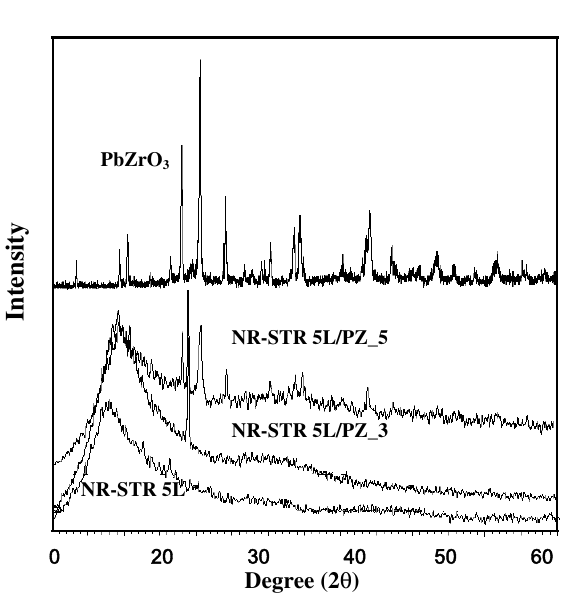
Fig. 2. XRD patterns of natural rubber (NR-STR 5L), lead zirconate (PbZrO 3 Þ , NR-STR5L/PZ 3, and NR-STR5L/PZ 5 composite